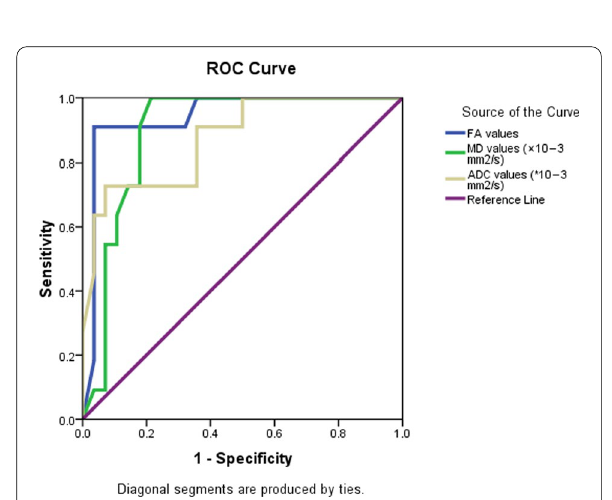
Fig. 2 ROC curve of FA, MD and ADC in differentiating grade 3 from grade 1 and 2 endometrioid